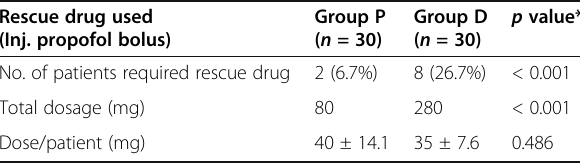
Table 2 Time to achieve desired RSS of 3-4 Time (in min) To achieve desired RSS of 3-4 (in min)